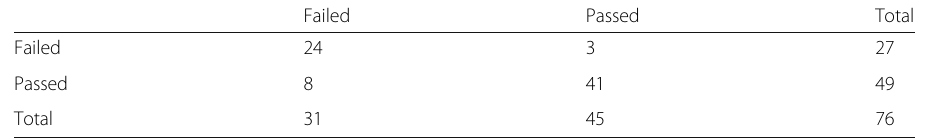
Table 11 Confusion Matrix for the kNN Algorithm* Failed Passed Total Failed 24 3 27 Passed 8 41 49 Total 31 45 76